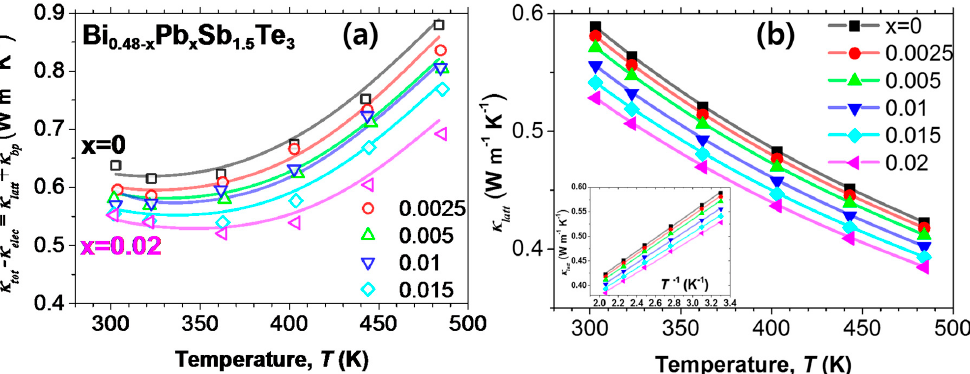
Figure 5. ( a ) ( κ tot - κ elec ) values of the samples (Figure 2b) with fitted values (lines); ( b ) Calculated value ( κ latt estimated by the Callaway model). The further 10% reduction is achieved by Pb doping ( x = 0.02). Inset shows the linear relationship between κ latt and (1/T). Table 2. Point defect contributions to the total relaxation rate ( τ total − 1 ) used to model κ latt of the samples.